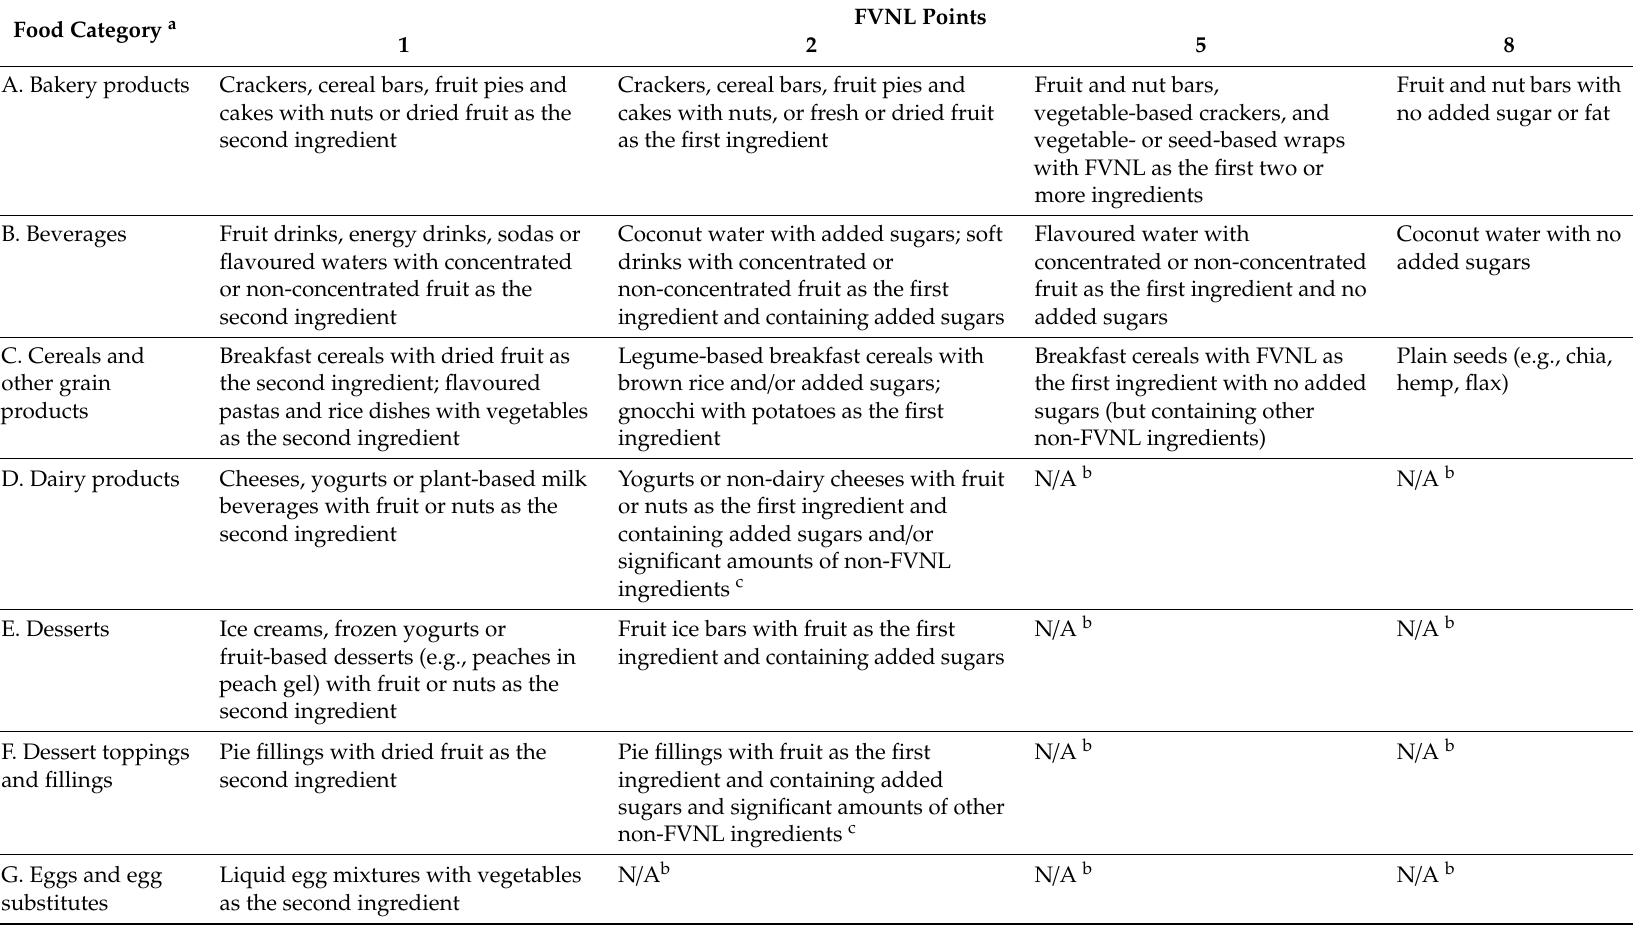
Table 4. Examples of types of Canadian packaged foods and beverages in each food category a that received 1, 2, 5 or 8 fruit, vegetable, nut and legume (FVNL) points, as defined by the Food Standards Australia New Zealand Nutrient Profiling Scoring Criterion and the Health Star Rating